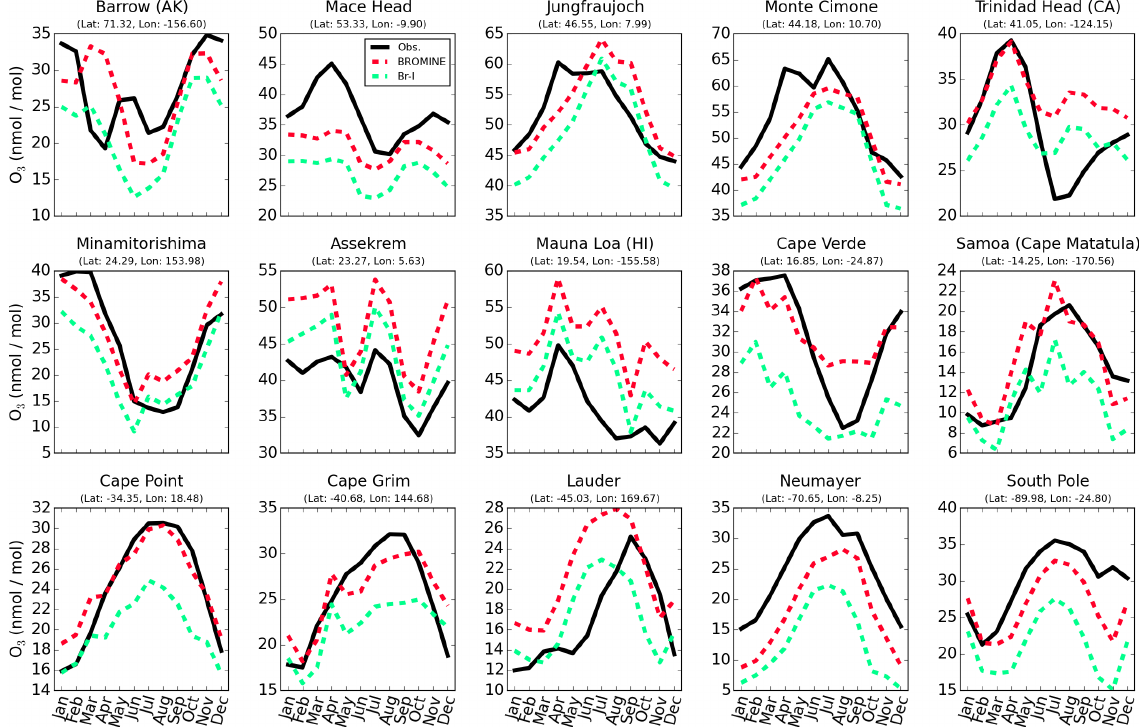
Figure 11. Seasonal cycle of near-surface O 3 at a range of Global Atmospheric Watch (GAW) sites (Sofen and Evans, 2015). Observational data shown are a 6-year monthly average (2006–2012). Model data are for 2005. Data are from GAW compile and processed as described in Sofen and Evans (2015). Red indicates standard GEOS-Chem (v9-2) including bromine chemistry (“BROMINE”) and green with inclusion of iodine chemistry (“Br +